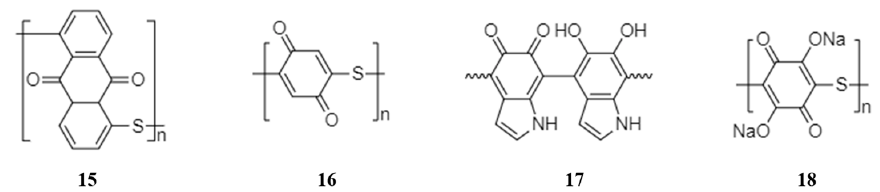
Figure 2. The structure of several polyquinones suitable for NIBs.